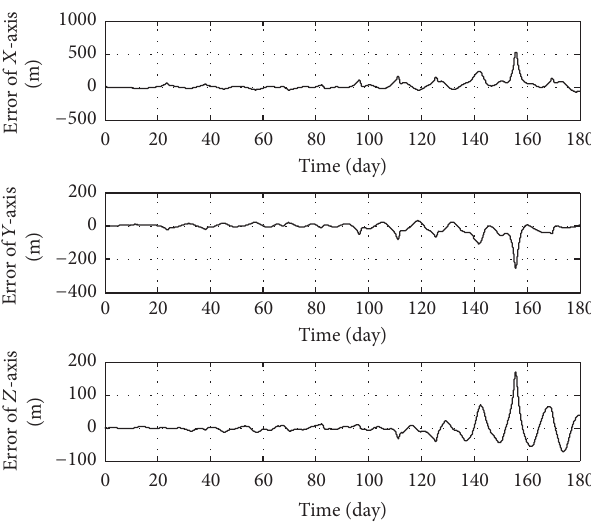
Figure 5: The AOD position error of 𝐿 1 using EKF.